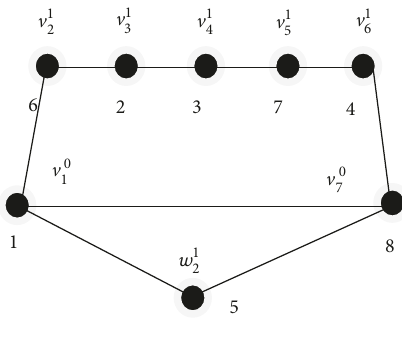
Figure 2: Bijective function 𝑓 1 (𝑥)